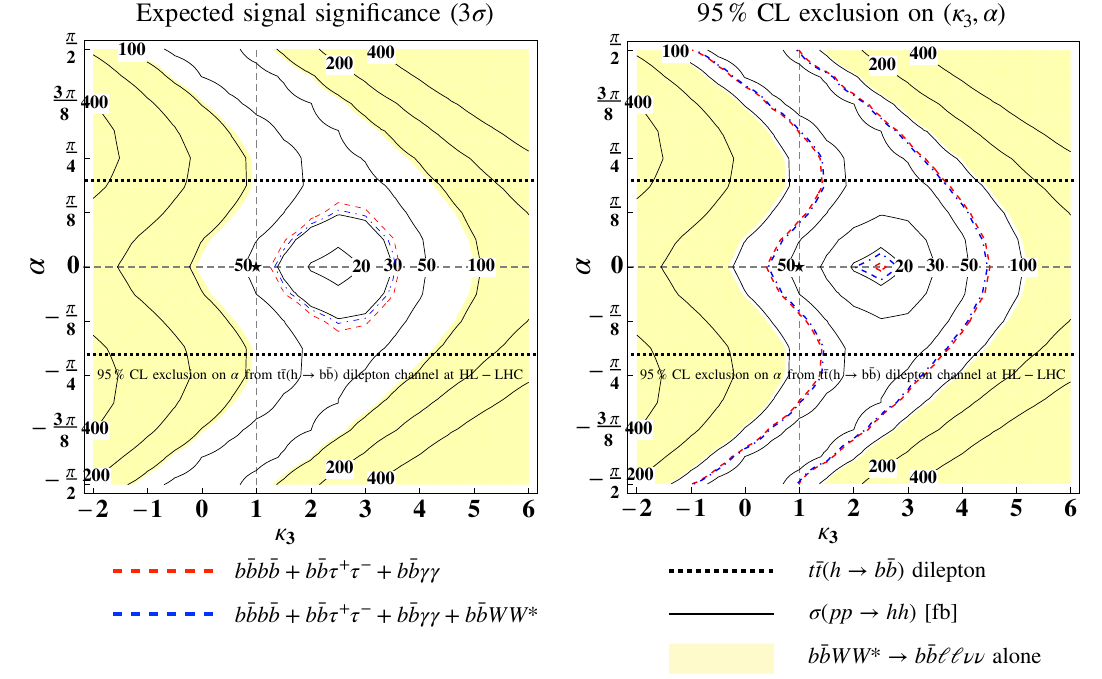
Figure 15 . Expected 3 σ significance of observing Higgs boson pair production (left) and 95% C.L. exclusion (right) in the ( κ , α ) plane at the HL-LHC with 3 ab − 1 . We used the binned log-likelihood 3 analysis with statistical uncertainties only, assuming the same efficiencies for all ( κ , α ) values as 3 one for ( κ ) = (1 , 0) (SM point denoted by ? ). Contours of the double Higgs production cross 3 , α section (in fb) are shown in black-solid curves. The yellow shaded region is obtained using results in this study for the dilepton channel ( hh → b ¯ bWW ∗ → b ¯ b‘‘ν ¯ ν ). The red dashed curve is obtained combining three channels, b ¯ bb ¯ b + b ¯ bτ + τ − + b ¯ bγγ following ref. [45], while the blue dashed curve includes all four channels. The horizontal-black dotted line represents a sample 95% exclusion on the CP angle from the dilepton channel of t ¯ th production with h → b ¯ b [103], | α | . 35 ◦